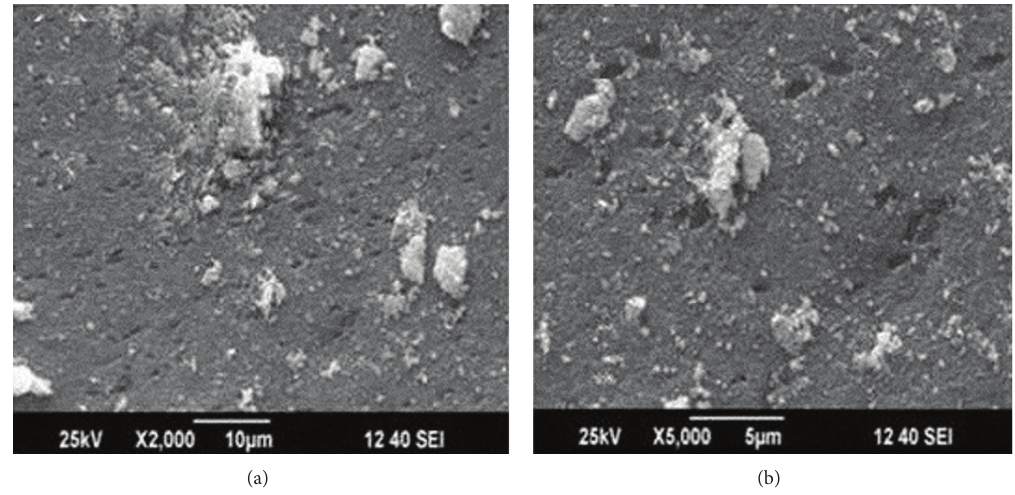
Figure 4: SEM image of silver nanoparticles shows spherical shape with agglomeration at different magnification, (a) 2,000x and (b) 5,000x.